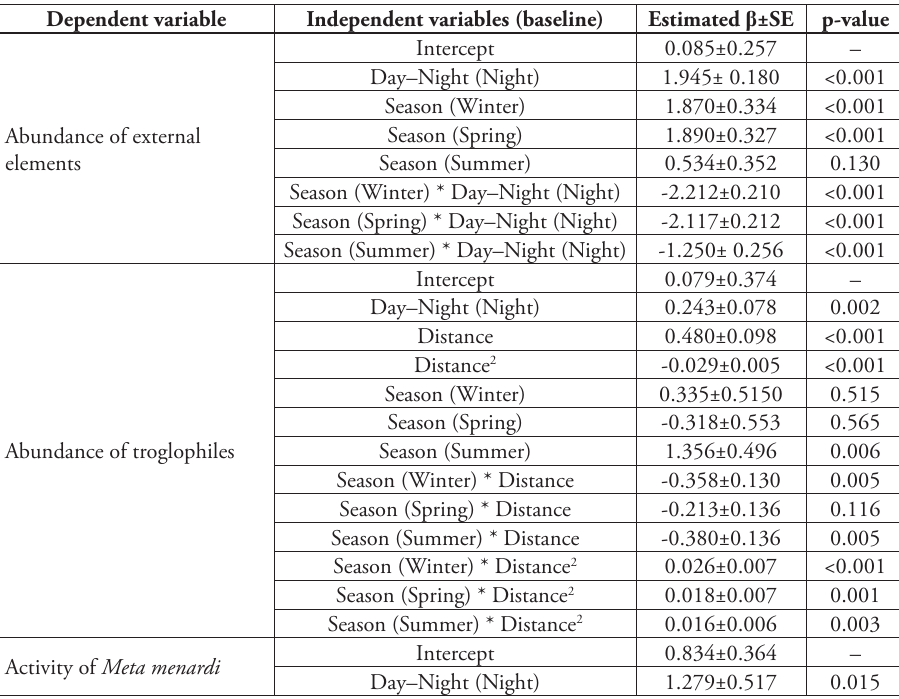
Table 2. For each model are shown significant variables included in the relative best AICc model. For the categorical variable Day–Night, the baseline is ‘day’. For the categorical variable Season, the baseline is ‘Autumn’. Variables excluded due to model selection or in the initial data exploration (collinearity analy- sis) are not shown. The symbol asterisk (‘*’) indicate an